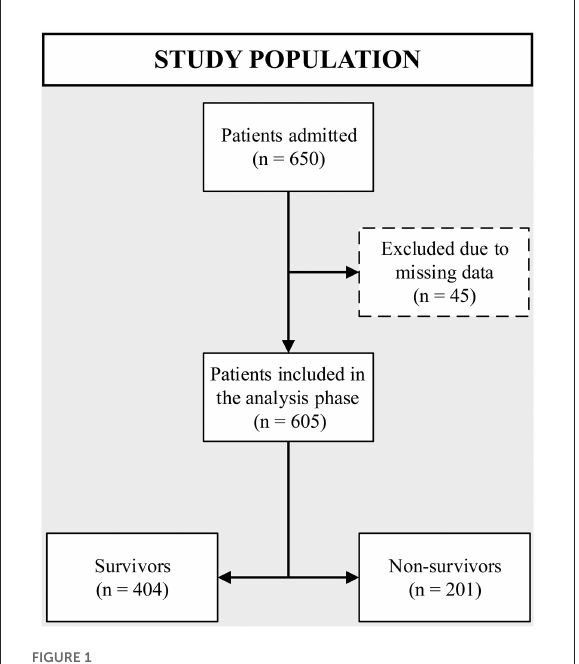
FIGURE1 Flow chart of study enrollment and analyzed